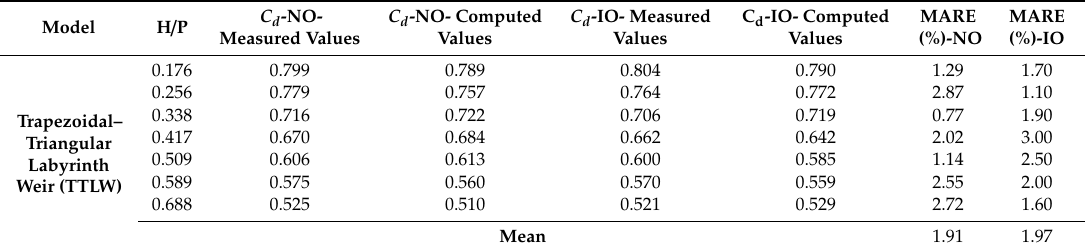
− = ×  (20) O = where O i and P i are measured and computed values, respectively, and N is the total number of data. Table 3 gives the results for MARE at different H/P ratio and weir orientation. Table 3. MARE Values for the discharge coefficient versus different H/P ratios on NO and IO orientation. Table 3. MARE Values for the discharge coe ffi cient versus di ff erent H / P ratios on NO and IO orientation. Model C d -NO- C d -NO- Computed C d -IO- Measured C d -IO- Computed MARE MARE Model H / P Measured Values Values Values Values (%)-NO (%)-IO